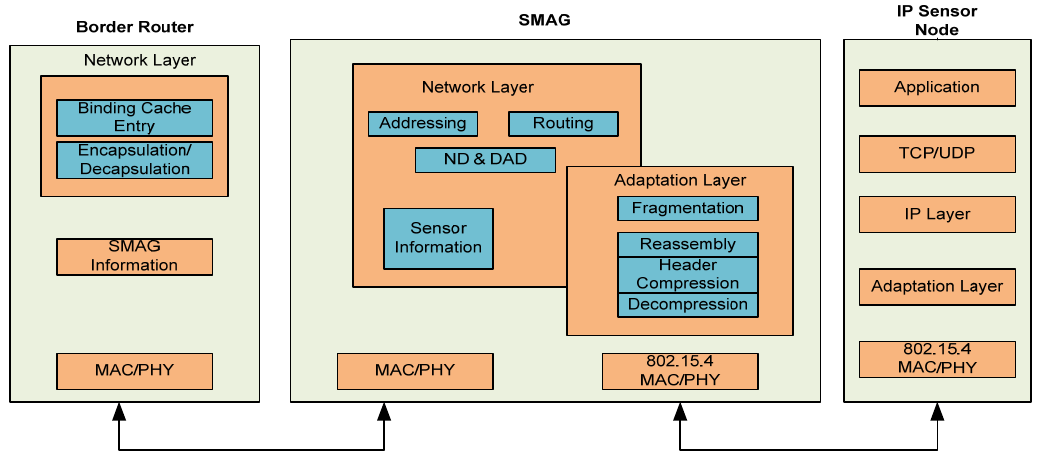
Figure 2. Software Architecture of global